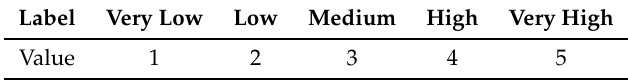
Table 1. Numeric values for corresponding linguistic variables.